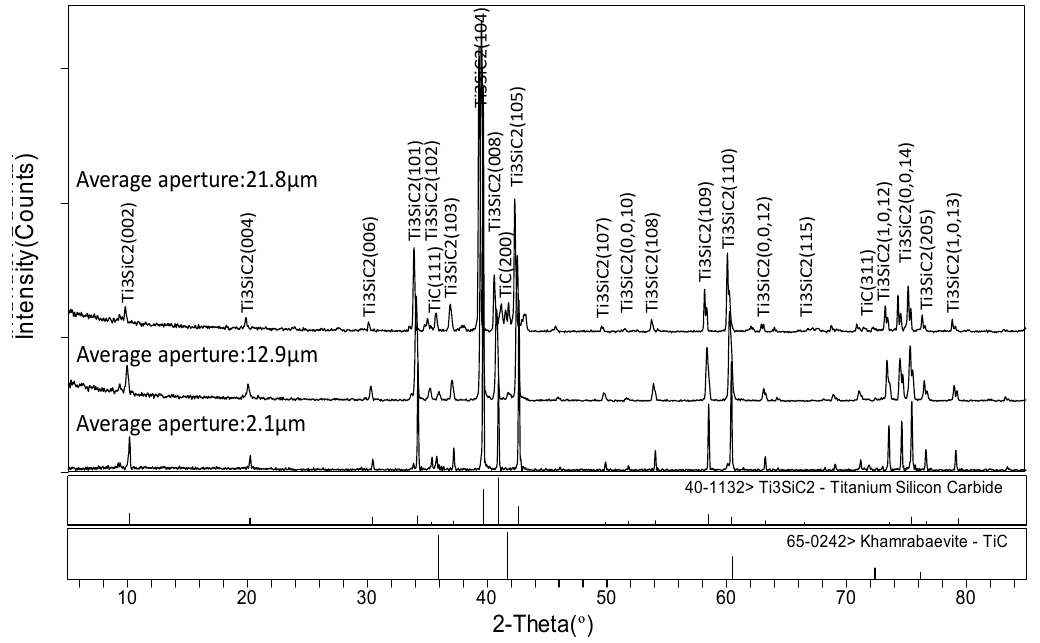
Figure 2. X-ray diffraction (XRD) patterns of porous Ti 3 SiC 2 with different average pore sizes. Figure 2. X-ray di ff raction (XRD) patterns of porous Ti 3 SiC 2 with di ff erent average pore